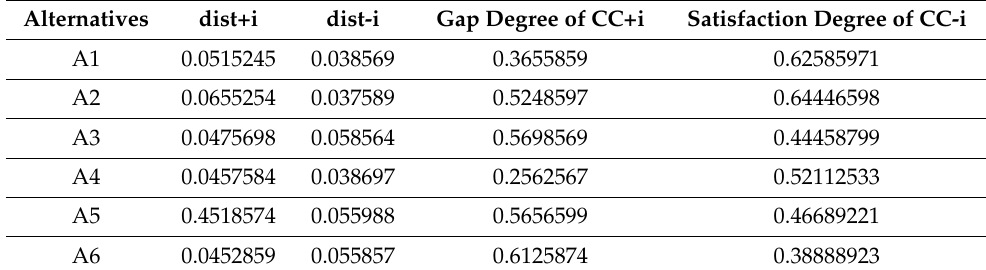
Table 17. Satisfaction degree for the aspired level among different